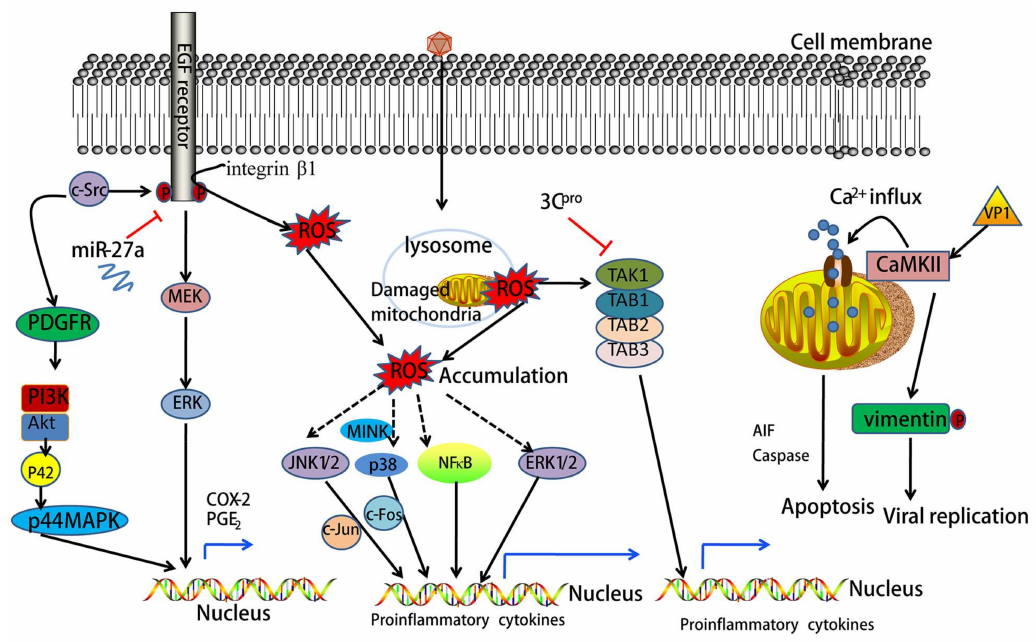
Figure 2. EV71 induces multiple cellular inflammatory signals and Ca 2+ -dependent signals. Epidermal growth factor receptor (EGFR)-dependent signaling plays an important role in the pathogenesis of inflammation through regulation of pro-inflammatory genes. EV71 infection induces cyclooxygenase-2 (COX-2) and prostaglandin E2 (PGE 2 ) overexpression through the c-Src/EGFR/MEK/ERK and c-Src/PDGFR/PI3K/Akt/p42/p44MAPK signal pathways. The activation of EGFR can be blocked by miR-27a. EV71 infection causes reactive oxygen species (ROS) accumulation through the integrin β 1/EGFR signals and mitochondrial damage. ROS activate JNK1/2, p38, ERK1/2, and nuclear factor-kappa B (NF- κ B) directly or indirectly, and further regulate the production of multiple proinflammatory cytokines. EV71-encoded 3C protease (3C pro ) inhibits pro-inflammatory cytokine gene transcription through interactions with TAK1/TAB1/TAB2/TAB2 complexes. EV71 initiates Ca 2+ -dependent signaling, and Ca 2+ influx. Additionally, EV71 induces host cell apoptosis by eliciting the apoptosis-inducing factor (AIF), Caspase-independent apoptotic pathway in mitochondria. The EV71 protein VP1 activates calmodulin-dependent protein kinase II (CaMKII) and further phosphorylates Vimentin, which facilitates EV71 replication. 3. EV71-Encoded Proteases Block Retinoic Acid-Inducible Gene I (RIG-I)-Like